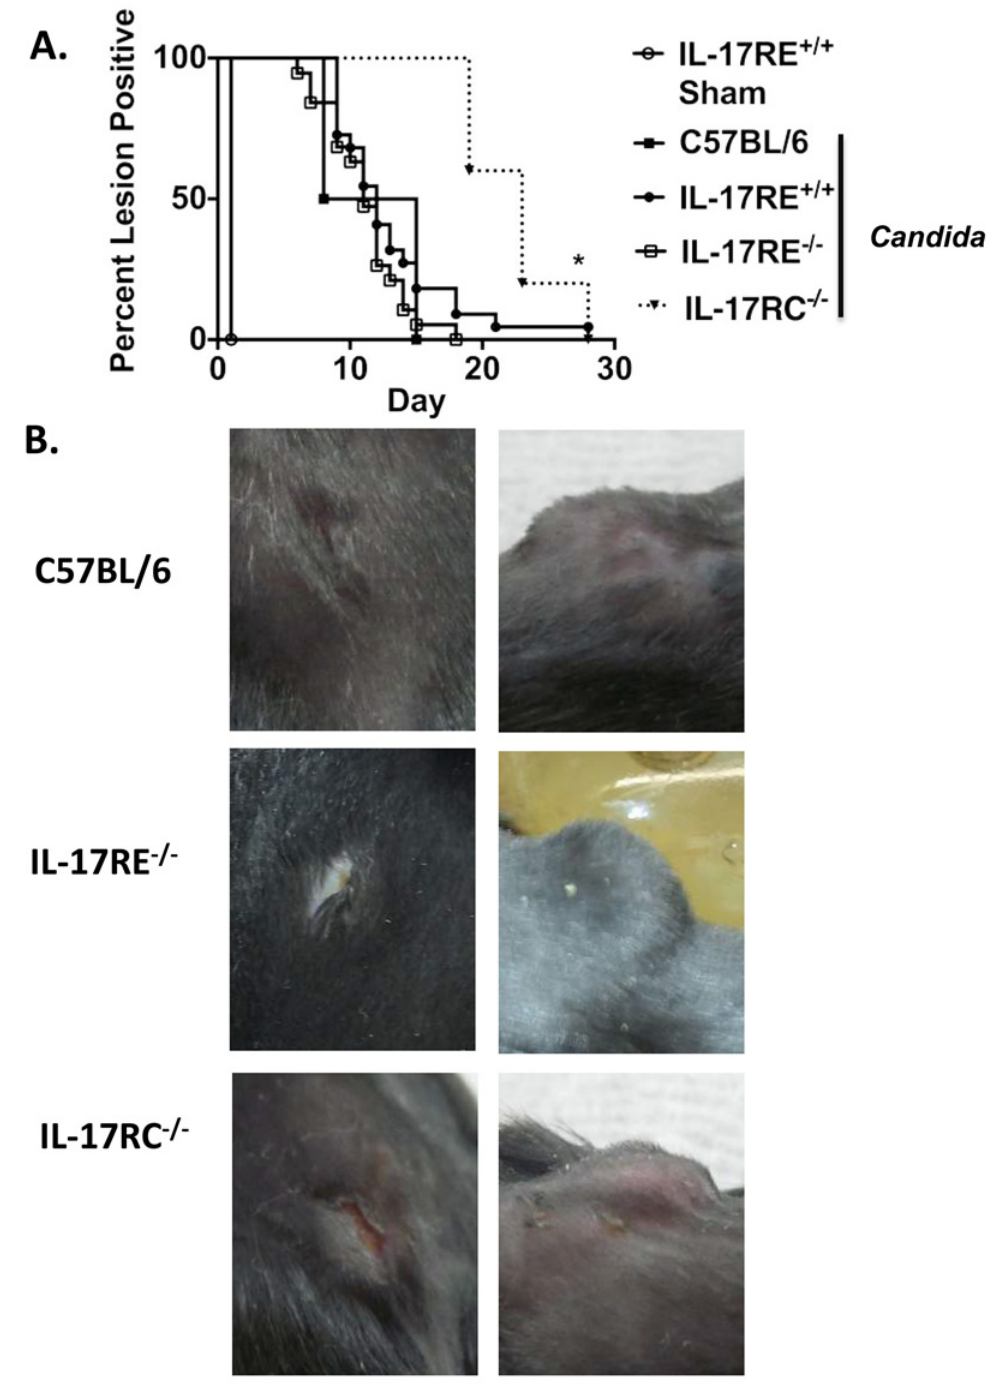
Fig 3. IL-17RE -/- mice are resistant to cutaneous candidiasis. A. The indicated mice were subjected to dermal candidiasis by subcutaneous injection with C. albicans strain CAF2-1 hyphae (IL-17RE +/+ Sham, n = 6; Infected: IL-17RC -/- , n = 5; C57BL/6 WT, n = 4; IL-17RE +/+ , n = 21; IL-17RE -/- , n = 19). The percent of mice positive for lesions over time is presented. * p < 0.01 compared to WT by a Log-rank (Mantel Cox) test. Graph depicts pooled data from two independent experiments. B. Ulceration (left panels) and nodule formation (right panels) are depicted in WT, IL-17RE -/- and IL-17RC -/- mice on days 4 and 6. Data are representative of two independent